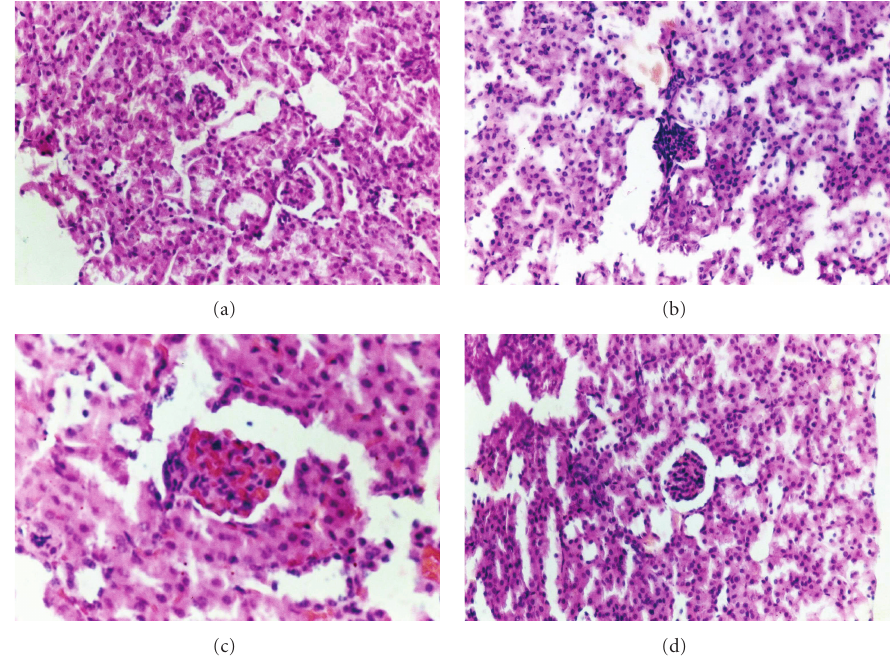
Figure 3: The kidneys collected at the time of sacrifice were stained with H&E for histological examination. (a) Normal control group (HE × 200). (b) Model control group (HE × 200). (c) Model control group (HE × 400). (d) MT group (HE ×